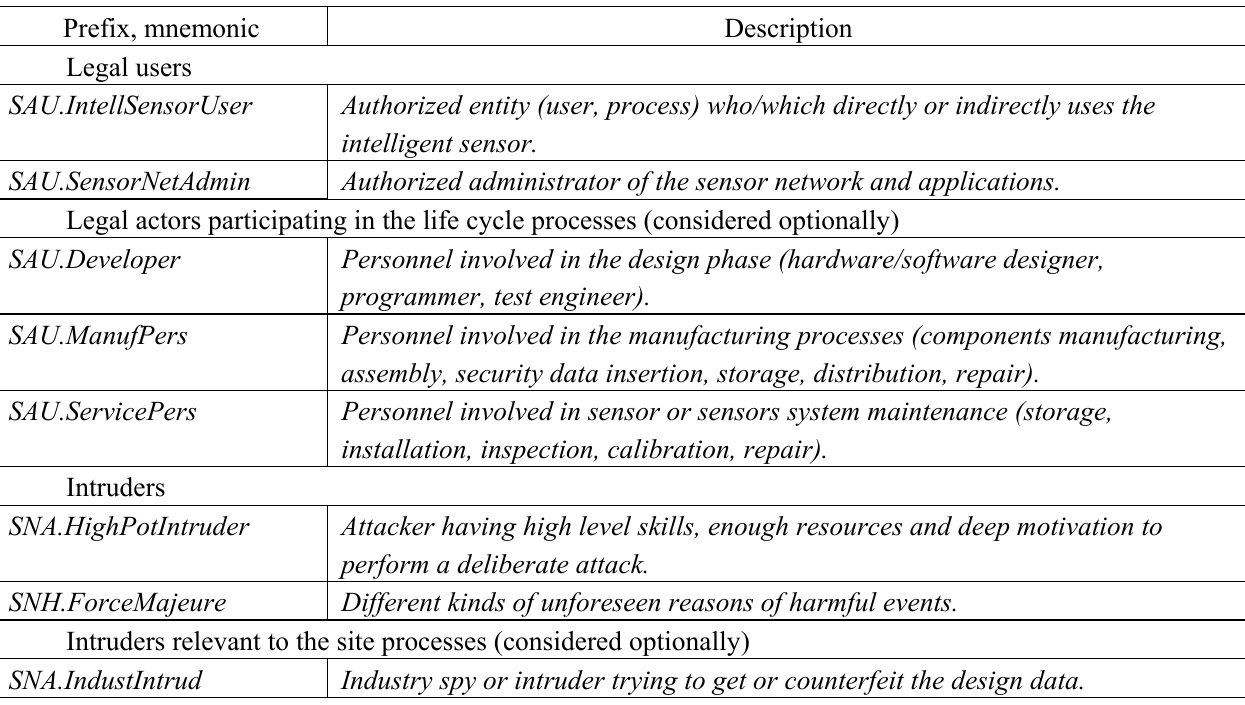
Table 9. Enhanced generics representing subjects, intruders and other active